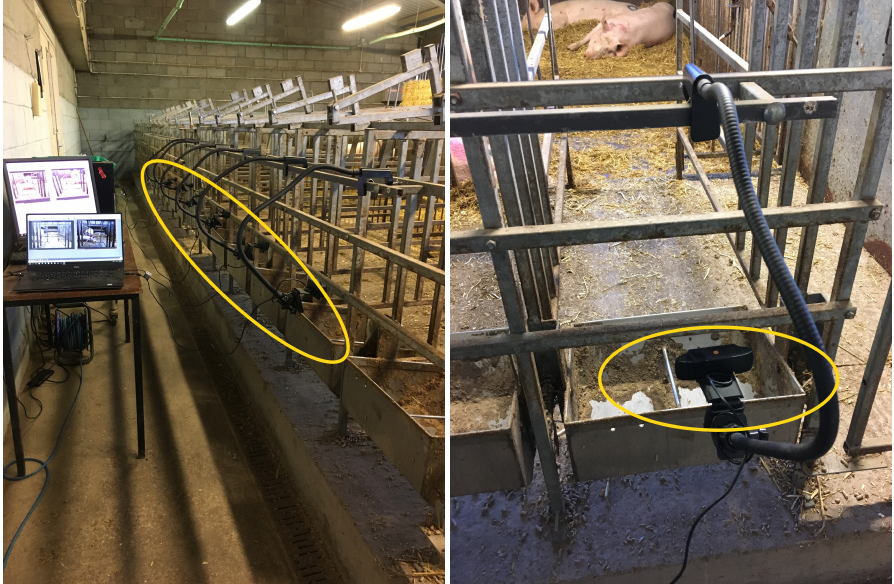
Figure 1. Image capture set-up. Six Logitech C920 HD Pro webcams positioned in front of individual feeding stalls. Image captured via iSpy Connect software installed on Dell Precision